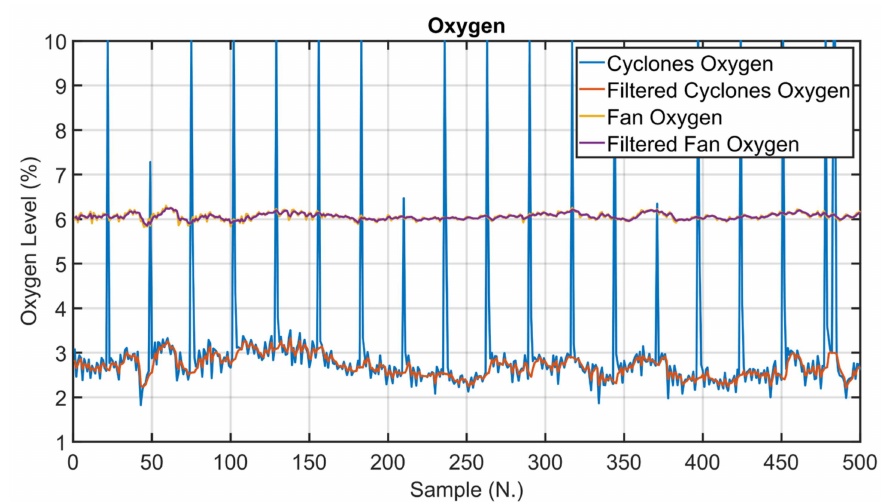
Figure 11. Rotary kiln APC system: data analysis results (oxygen).